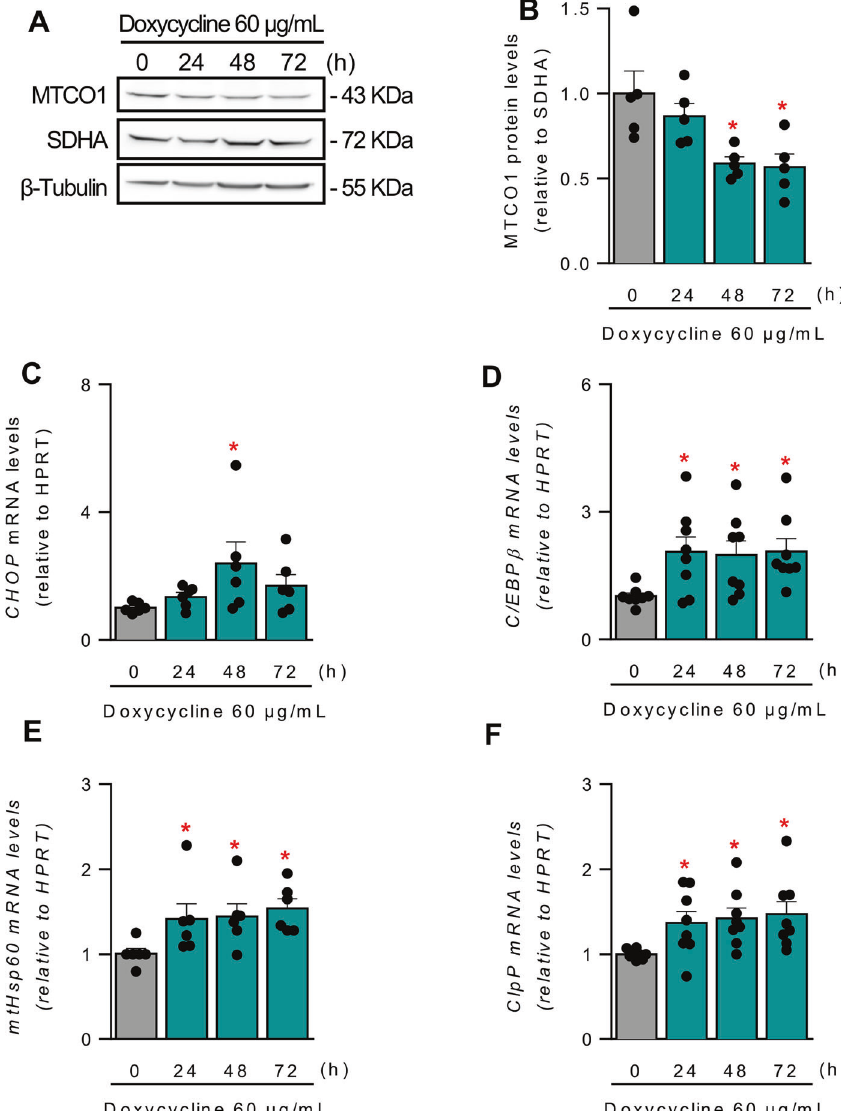
Fig. 5 Doxycycline induces mito-nuclear protein imbalance and transcriptional mitochondrial stress response. A , B HeLa cells were treated with 60 µg/mL doxycycline for the indicated times, and MTCO1 (mitochondrial DNA-encoded) and SDHA (nuclear DNA-encoded) levels were analyzed by western blotting using β -tubulin as a loading control. A Representative blot. B Densitometric quanti fi cation ( n = 5). C − F HeLa cells were treated with 60 µg/mL doxycycline for the indicated times, and the relative mRNA levels of chop ( C ) , c/ebp β ( D ) , mtHsp60 ( E ), and clpp ( F ), as markers for mtUPR, were analyzed by RT-qPCR, using hprt as a reference gene ( n = 5 – 8). Results are shown as mean ± s.e.m. * P < 0.05 versus control